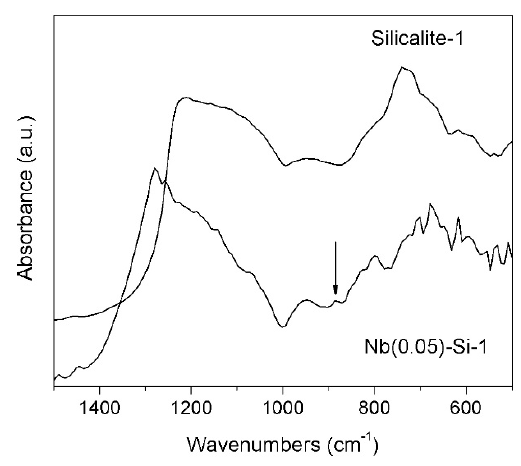
Figure 6. FTIR spectra of Silicalite-1 and Nb-Si-1 samples.